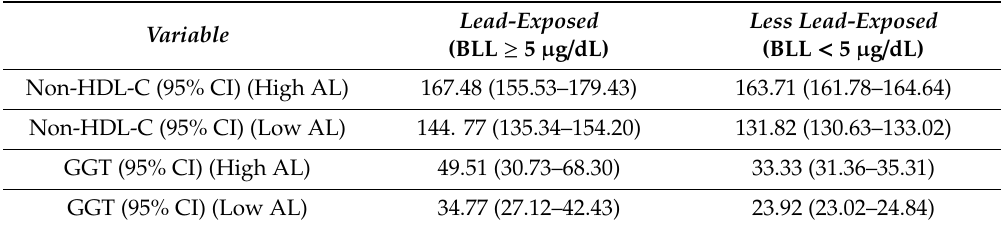
Table 2. The geometric mean values of lead-exposed vs. less lead-exposed among those with high and low AL for clinical variables of